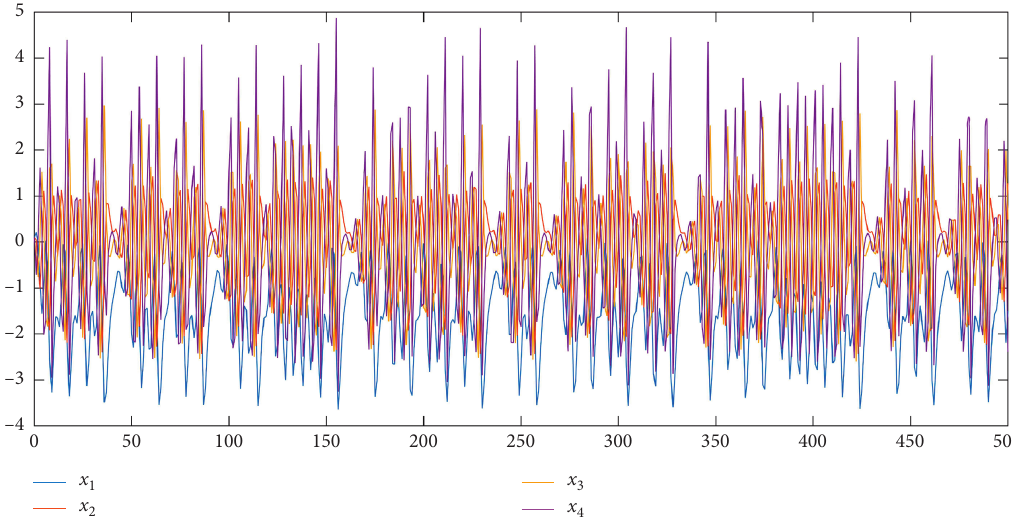
( 0 ) , x ( 0 ) , x ( 0 ) , x ( 0 )) � ( 0 . 1 , 0 . 1 , 0 . 1 , 0 . 1 ) and parameter values a � 1.4, b � 3, 1 2 3 4